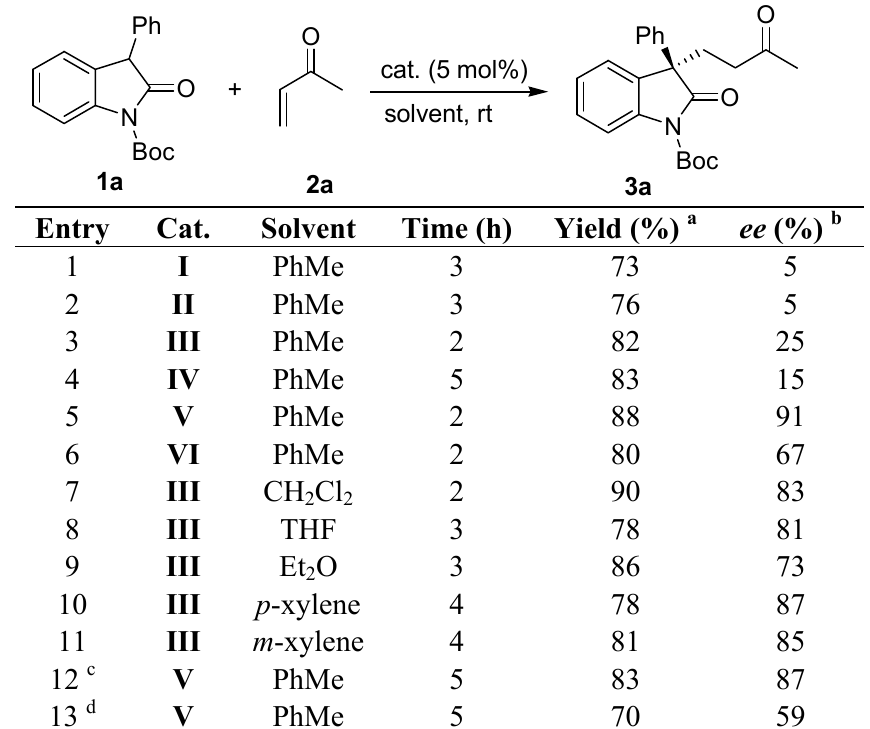
Table 1. Optimization of the reaction